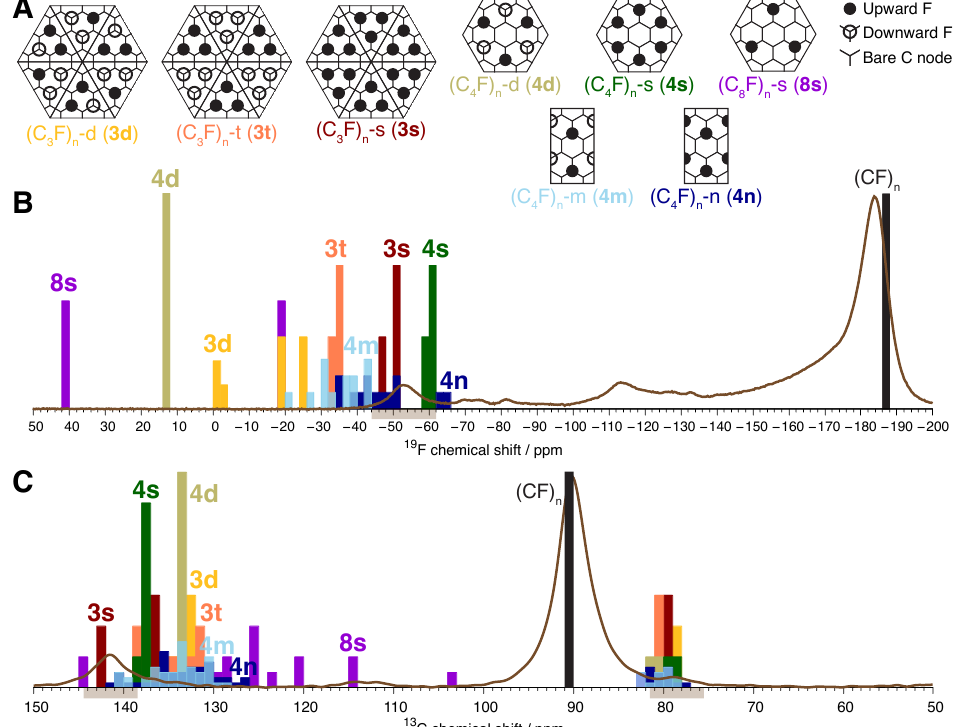
Figure 6. Overview of calculated chemical shifts for fluorographene models of distinct atomic arrange- ments of isolated − > CF groups. ( A ) Eight fluorine patterns consistent with our experimental inferences. ( B ) Histograms of 19 F chemical shifts calculated for molecular models incorporating the atomic ar- rangements of panel A overlaid on the experimental 19 F centerband NMR spectrum of GF-1h773. ( C ) Histograms of calculated 13 C chemical shifts overlaid on the experimental reconstructed 13 C CP CPMG MAS NMR spectrum of GF-1h773. Colored bars match to results corresponding to fluorine patterns in panel ( A ) as indicated. Black bars plot the calculated chemical shifts of hexagonal (CF) n (pattern not shown). Brown axis shading guides the eye to chemical shifts assigned to the new GF